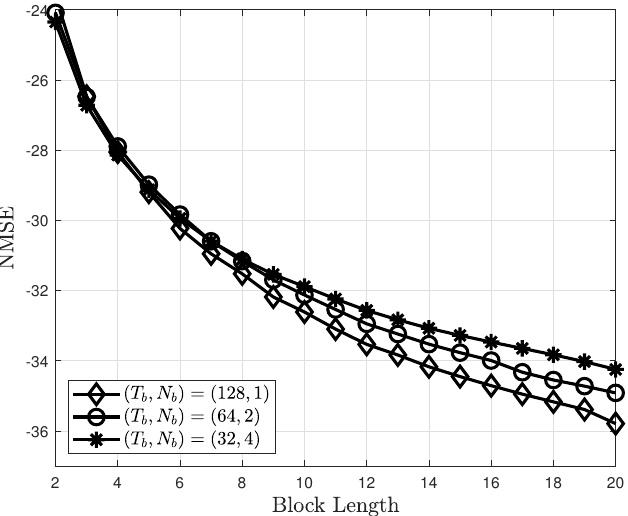
Figure 7. NMSEs of the proposed channel estimator for different T b and N b . The NMSE of the proposed channel estimator based on the number of backup samples is shown in Figure 8. Noticeably, the NMSE is improved as the number of backup